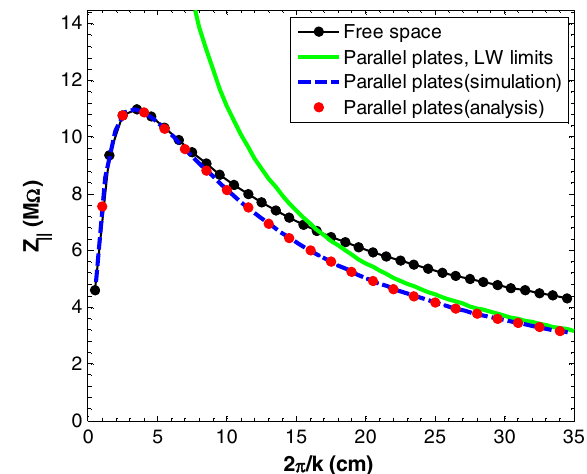
FIG. 7. Comparison of the average LSC impedances of a round SIR beam with beam radius a ¼ 0 . 5 cm under different boundary conditions and in different wavelength limit. The full height of the parallel plates is 4.8 cm. In the legend, “ Free space ” , and “ Parallel plates ” are boundary conditions; “ LW limits ” stands for the long-wavelength limits; “ (analysis) ” and “ (simulation) ” stand for the theoretical result and simulation (FEM) method, respec- tively. The theoretical result is consistent with the simulation in the entire wavelength